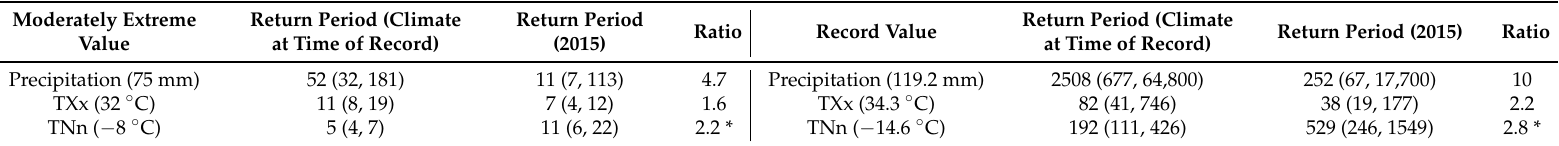
Table 7. Return period and ratios between the return periods (between 2015 and the point in time which the WP record was set: 1990 for TXx, 1895 for TNn and 1973 for RX1Day) for the individual record climate values set at WP and also for posteriori determined “moderate” extreme values (a threshold of 75 mm, 32 ◦ C and − 8 ◦ C for precipitation, TXx and TNn, respectively) with a return period of approximately a decade which have more tightly constrained 95% confidence interval estimates. * indicates the ratio has been inversed so less likely TNn events are given as positive ratios to match TXx and